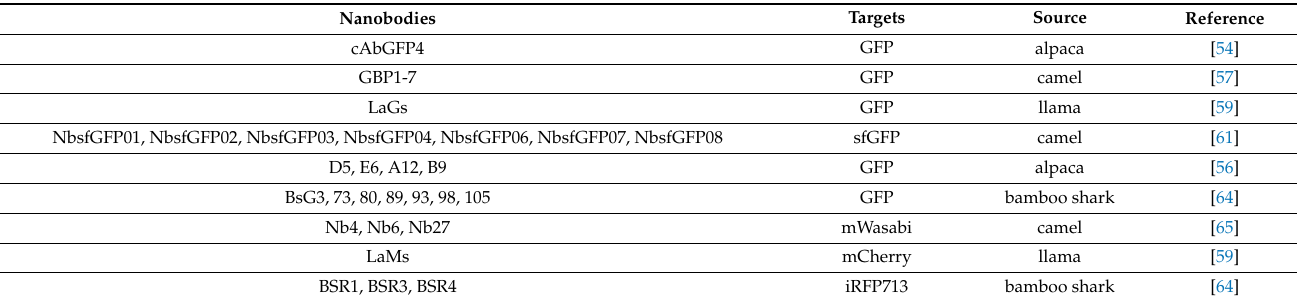
Table 3. Summary of nanobodies targeting